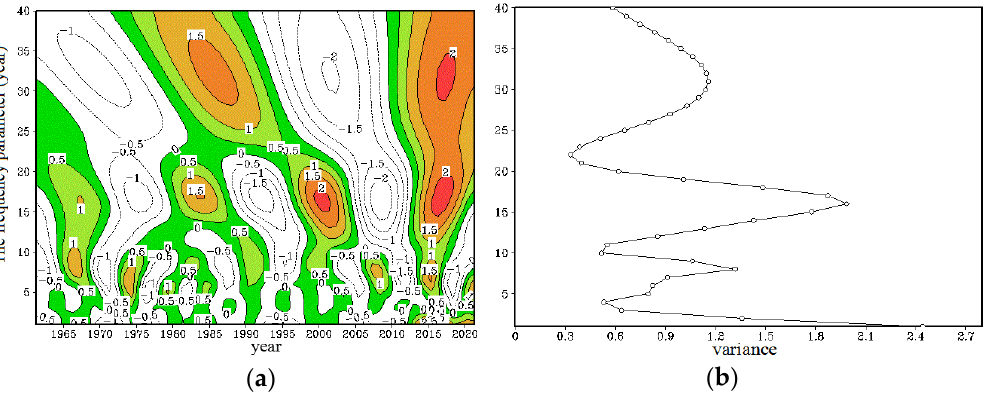
Figure 4. The wavelet real part ( a ) and wavelet variance ( b ) of the rainstorms and floods in the summer half-year of